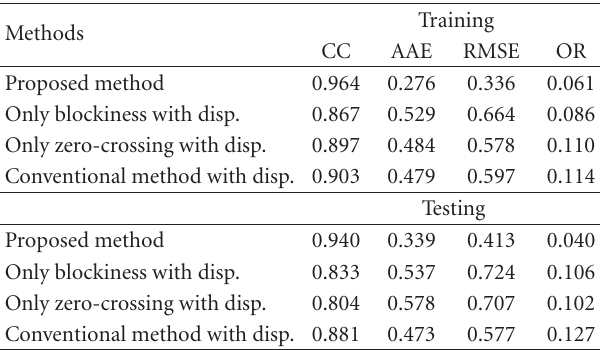
Table 4: Methods’ evaluation results for training and testing without (wo) disparity.